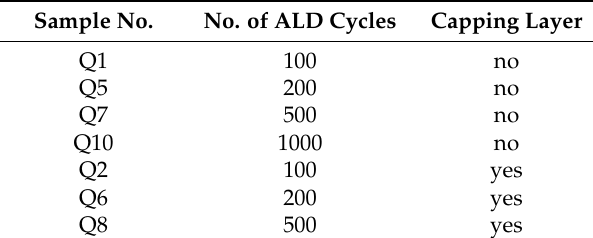
Table 1. Deposition parameters for films on quartz substrates. Sample No.